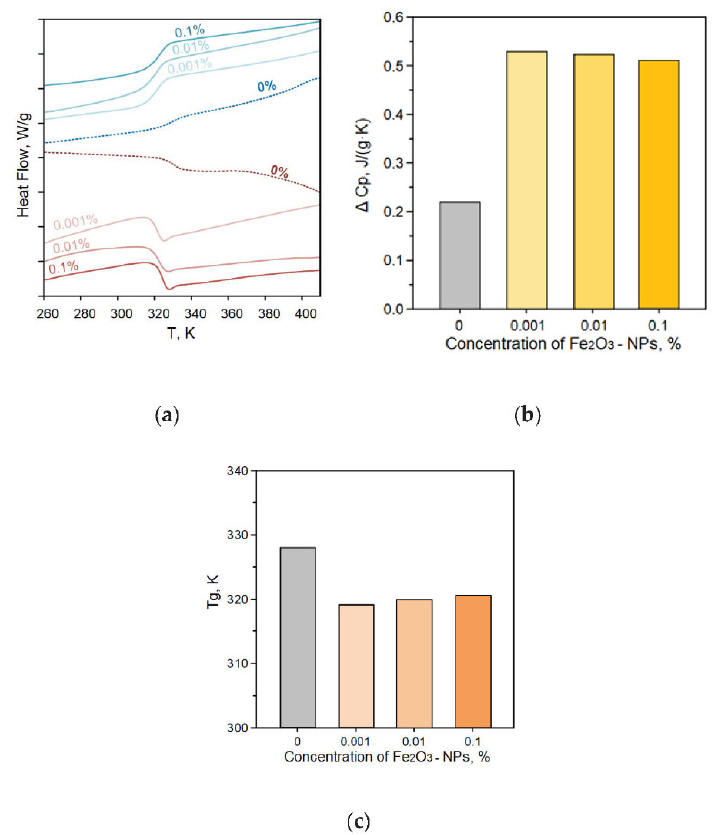
Figure 5. Results of thermal analysis of synthesized composite materials; ( a ) thermograms obtained in the mode of heating and cooling of the material based on PLGA and iron oxide nanoparticles with different concentrations; ( b ) and ( c ) dependences of the heat capacity and glass transition temperature on the concentration of nanoparticles in the samples.